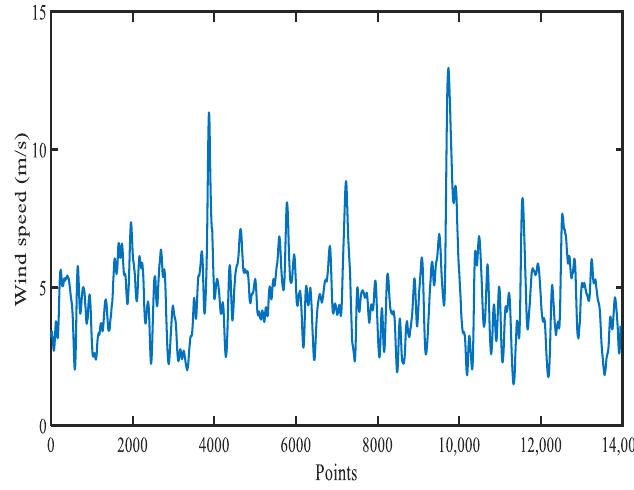
Figure 6. Actual wind speed of the wind turbine.